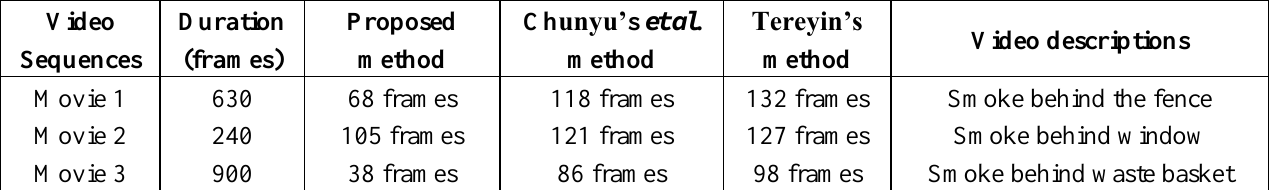
Figure 12. Video sequences used to obtain the evaluation results shown in Table